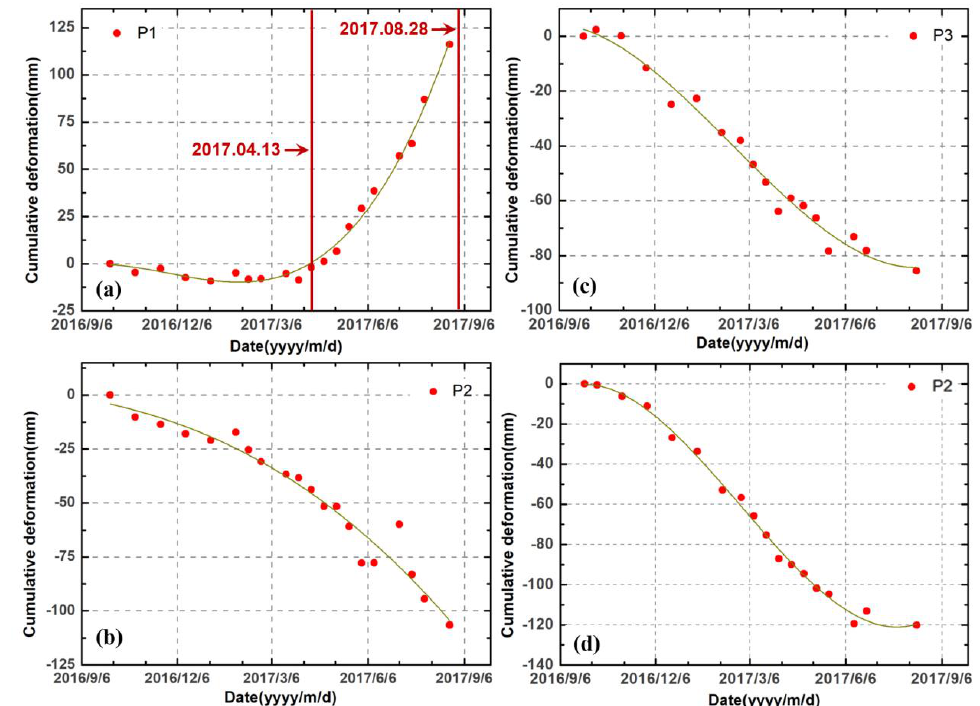
Figure 10. Precursory deformation time series of the Pusa landslide for P1 (( a ): ascending), P2 (( b ): ascending, and ( d ): descending) and P3 (( c ): descending). The ascending time series is from 3